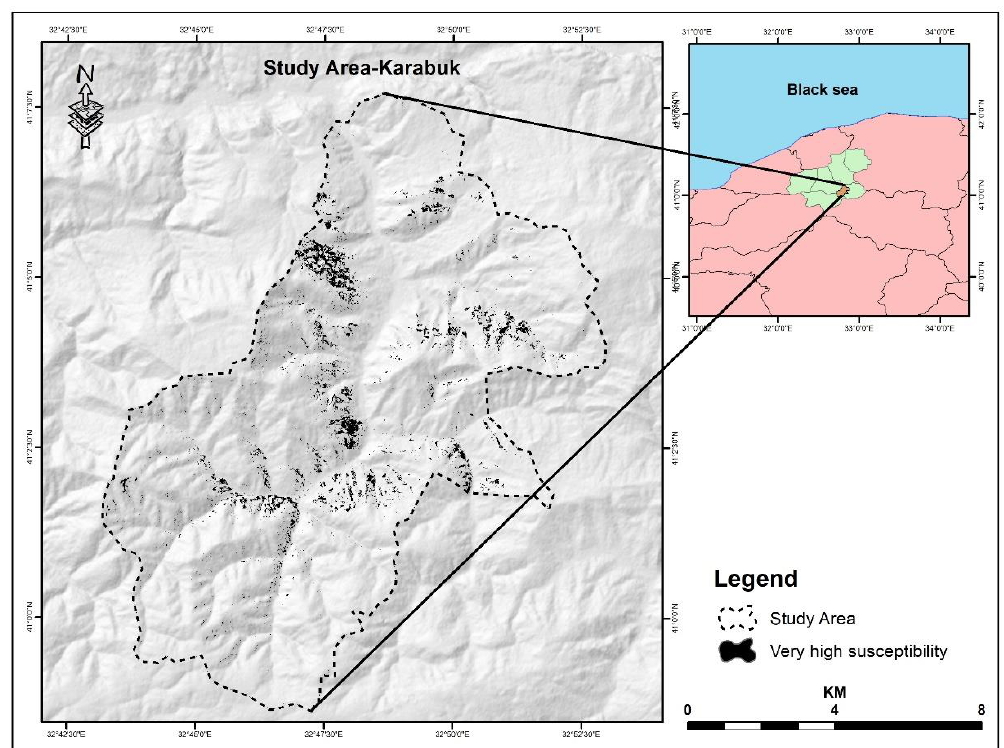
Figure 5 Very high landslides susceptibility